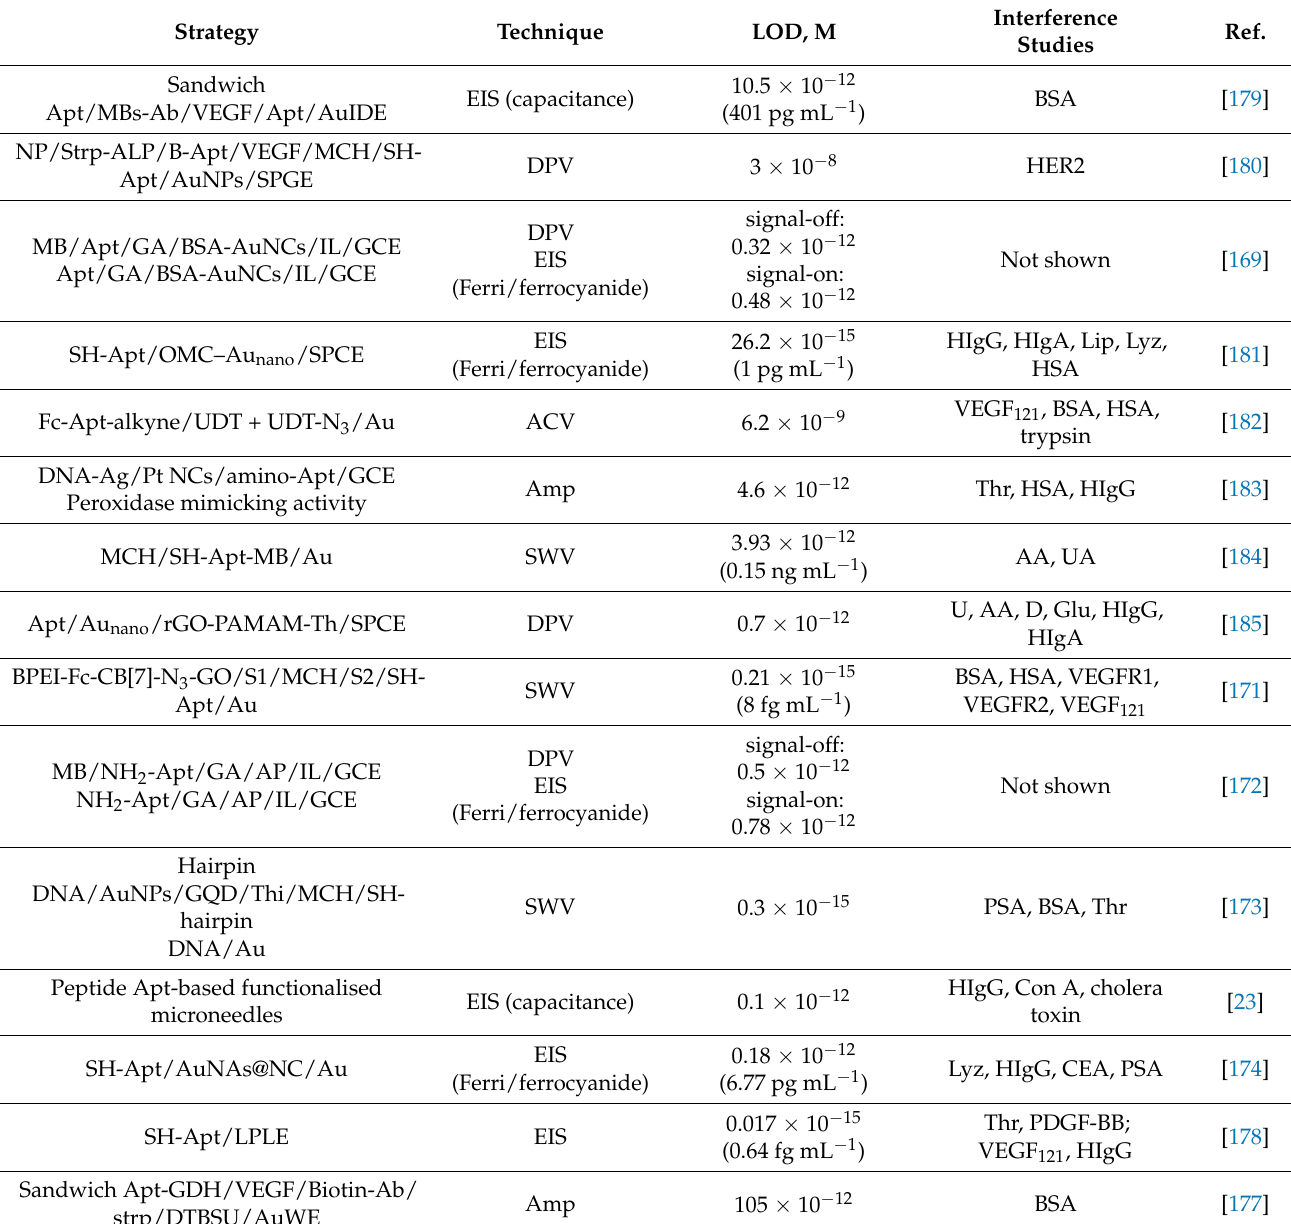
Interference Studies